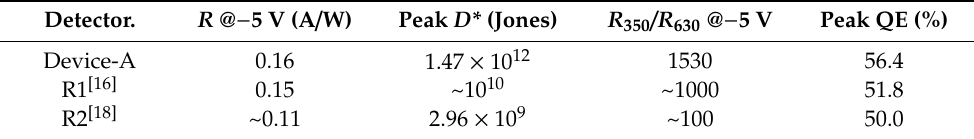
Table 1. A comparison of GaN UV detectors from present study with reports from the literature. Detector.